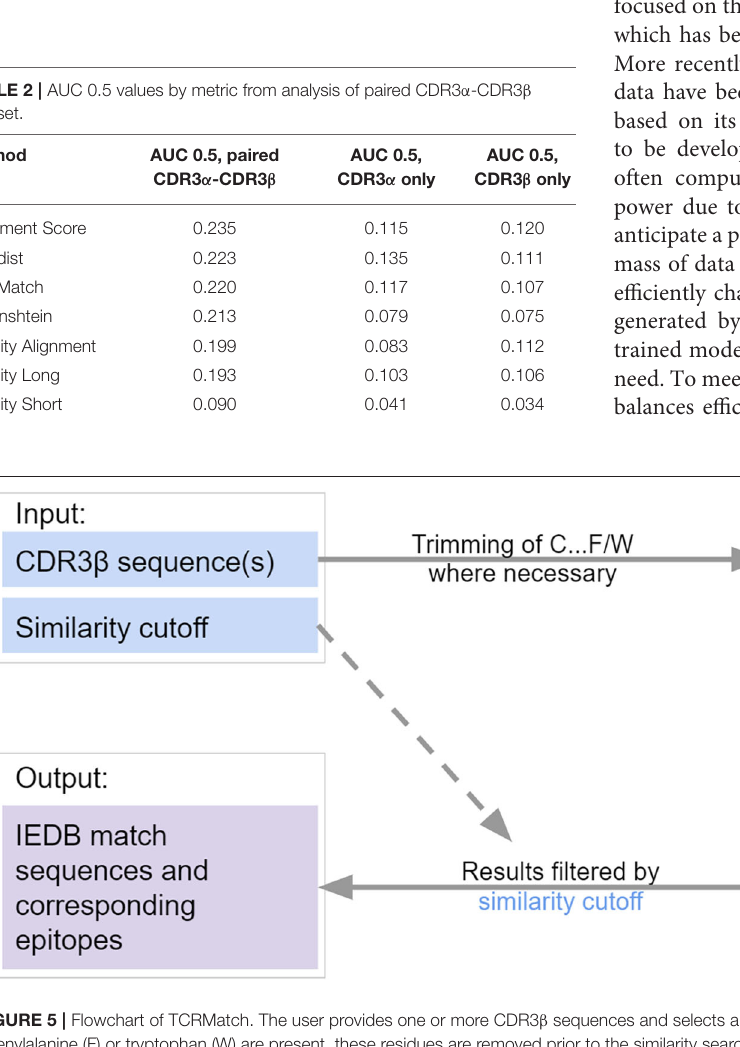
Frontiers in Immunology |